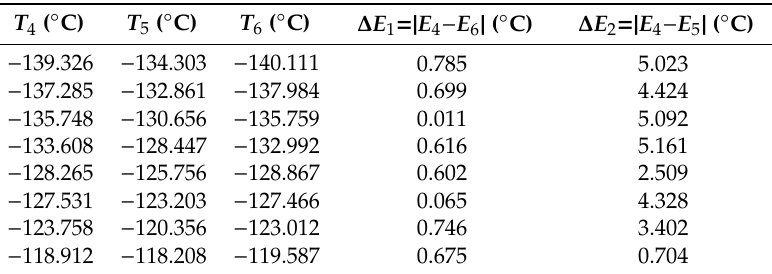
Table 3. Errors based on Equations (10 ) and (16).